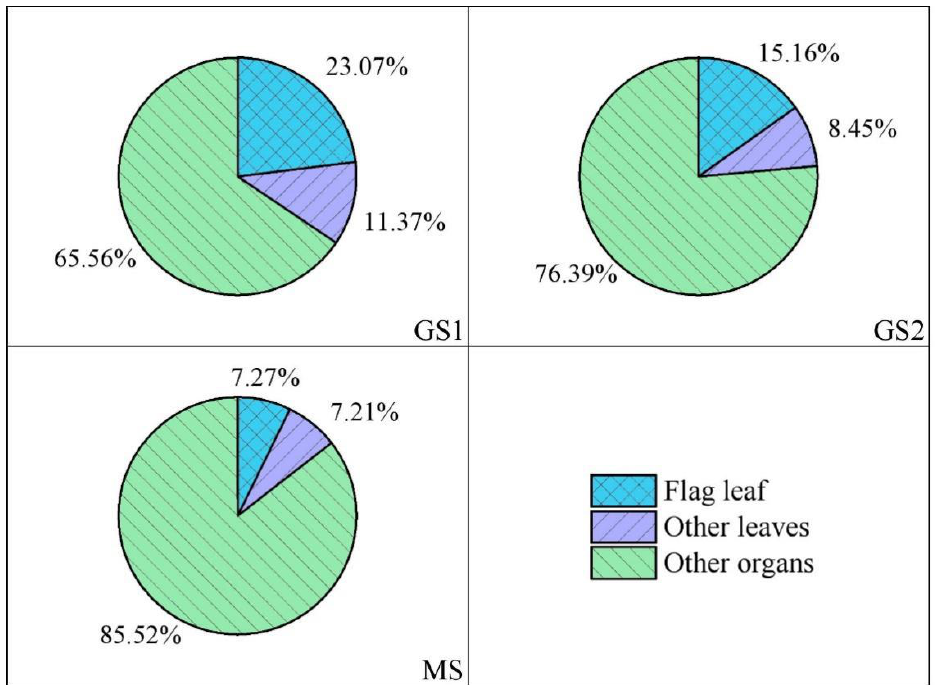
Figure 6. Relative contribution of wheat leaves-to-grain Cd. Note: GS1 = early grain filling stage, GS2 = middle grain filling stage, MS = mature stage.